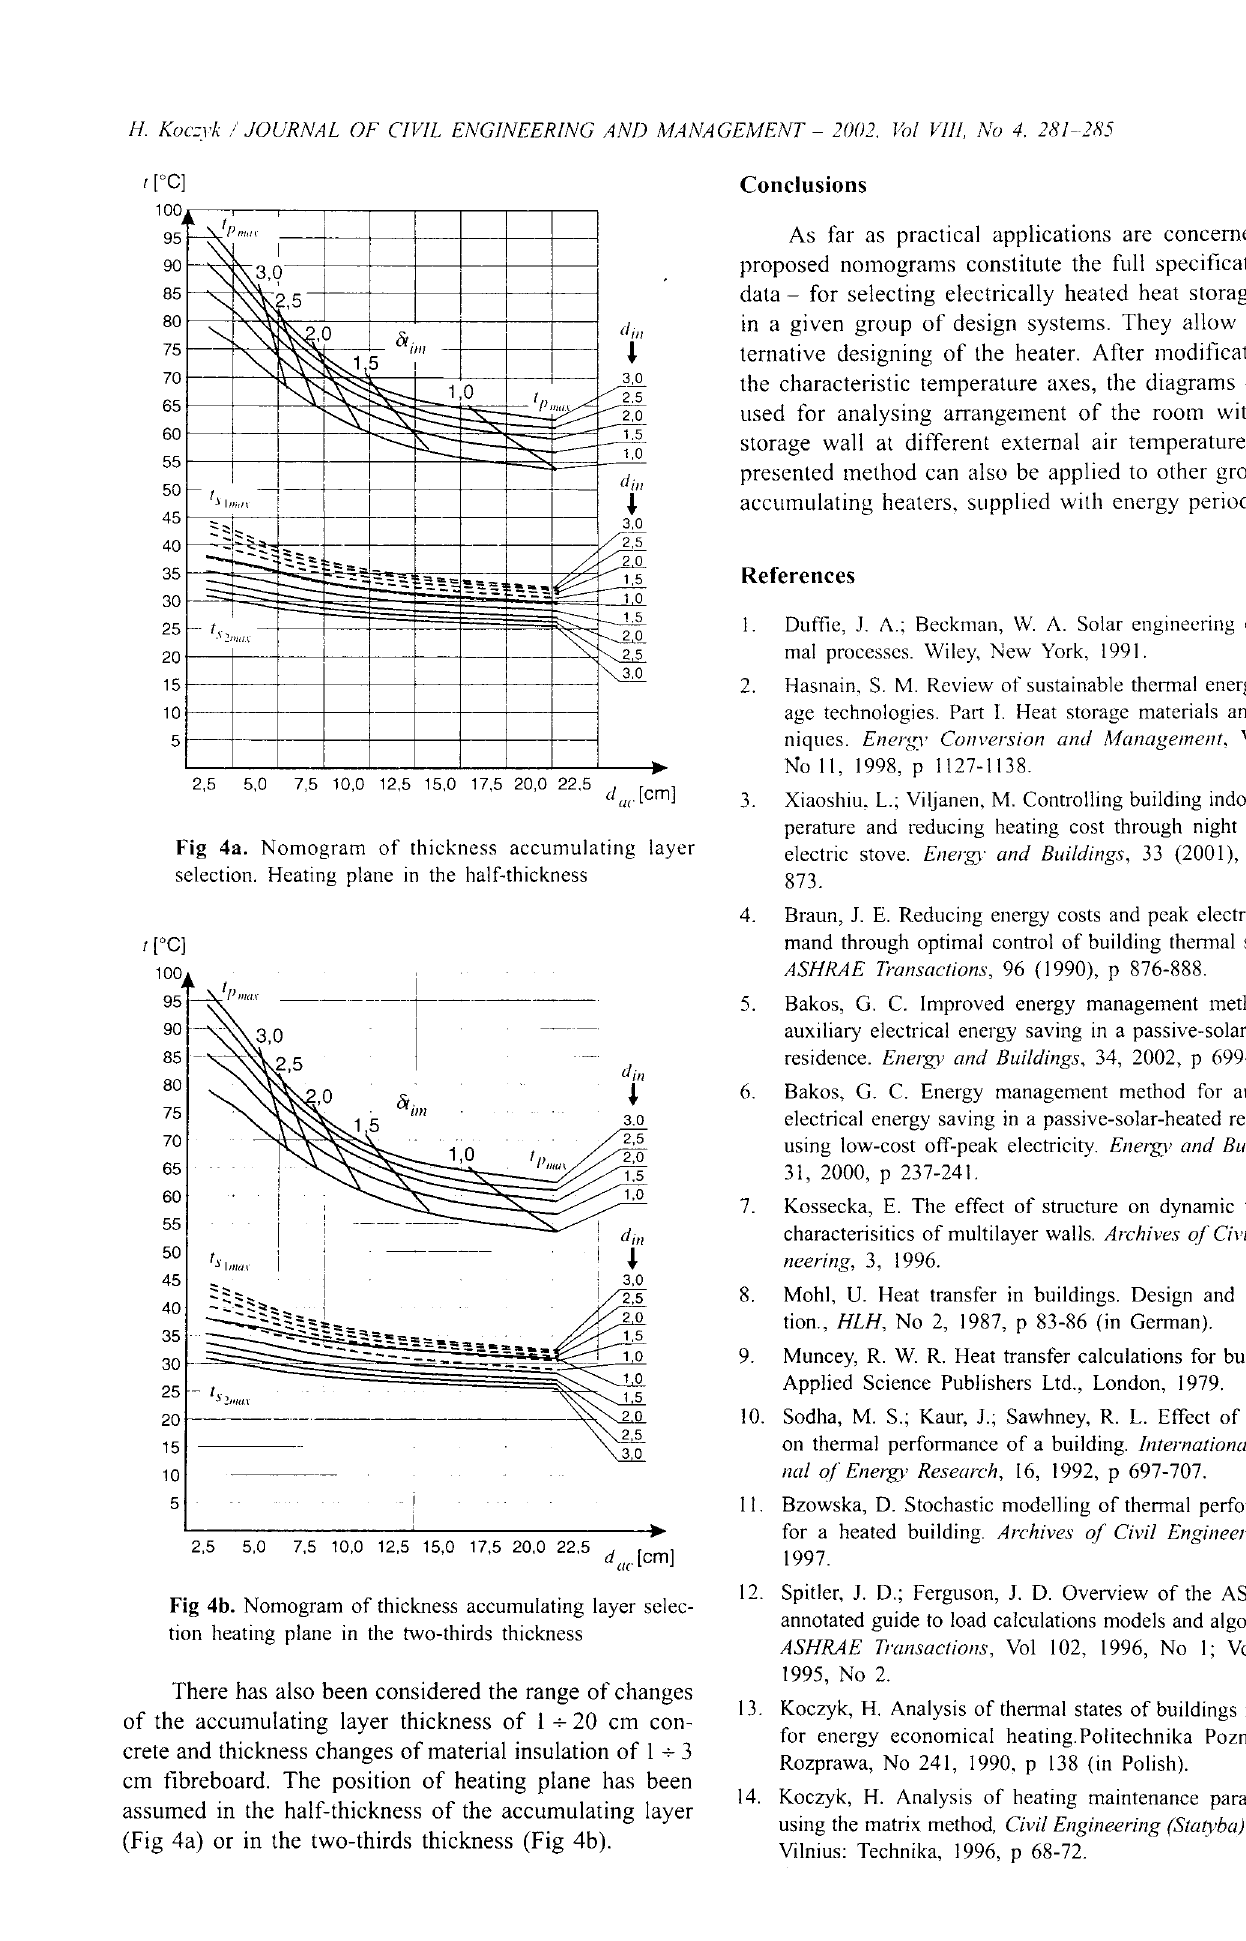
Fig 4b. Nomogram of thickness accumulating layer selec tion heating plane in the two-thirds thickness There has also been considered the range of changes of the accumulating layer thickness of l + 20 em con crete and thickness changes of material insulation of l + 3 em fibreboard. The position of heating plane has been assumed in the half-thickness of the accumulating layer (Fig 4a) or in the two-thirds thickness (Fig 4b